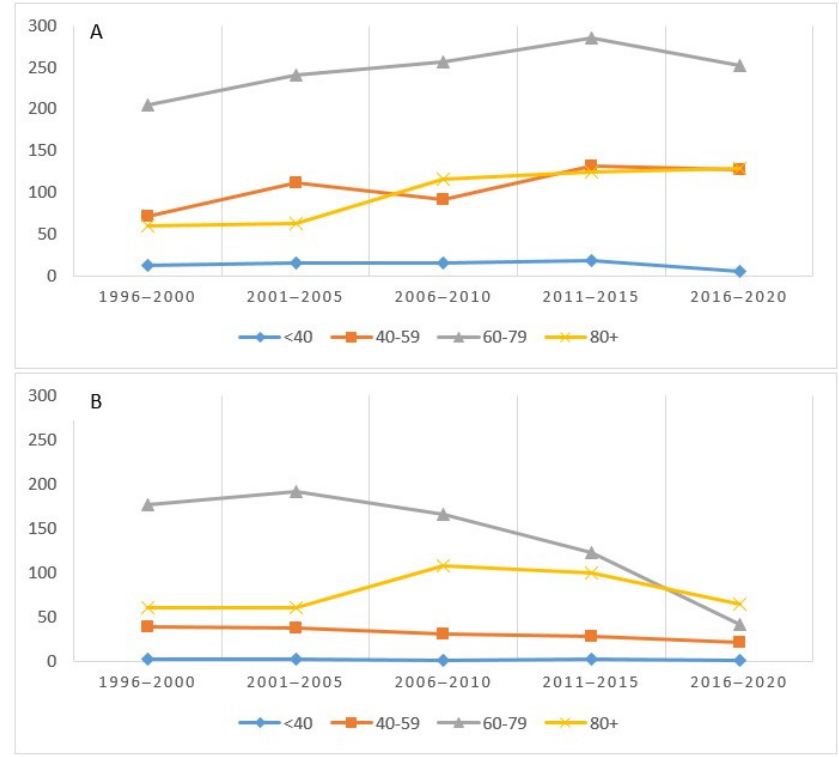
Figure 4. Number of cases (incidence ( A ) and mortality ( B )) by age group and period in the Province of Reggio Emilia.